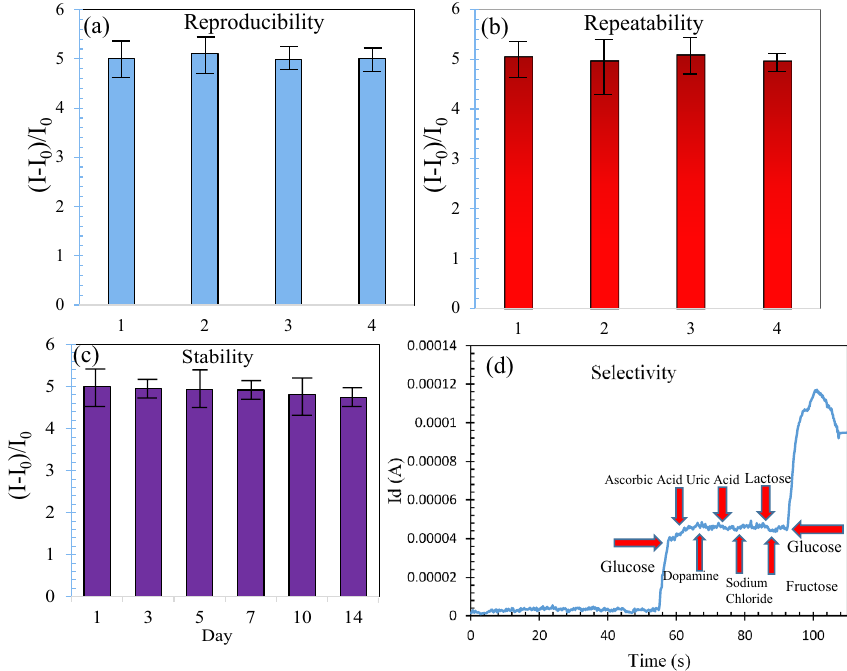
Figure 15. ( a ) Repeatability, ( b ) reproducibility, ( c ) stability, and ( d ) selectivity of the flexible FET sensor.